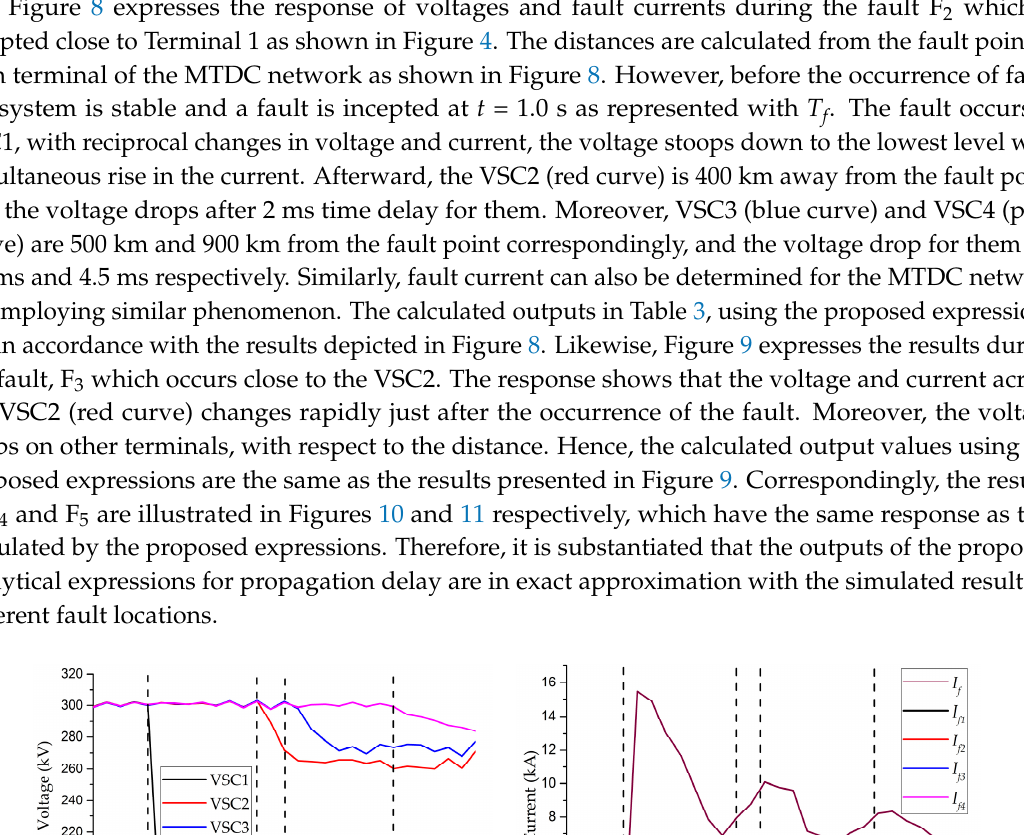
( b ) Figure 10. Propagation time delay in MTDC network in case of fault near VSC3. ( a ) Voltage response, ( b ) current response. ( a ) ( b ) Figure 11. Propagation time delay in MTDC network in case of fault near VSC4. ( a ) Voltage response, ( b ) current response.